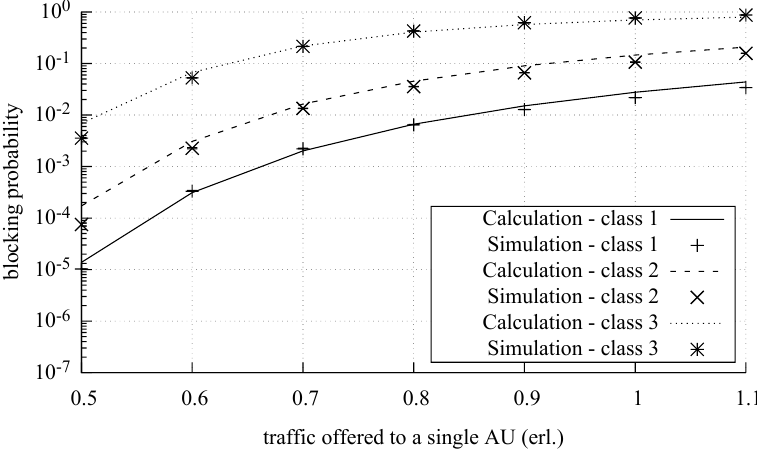
Figure 8. Blocking probability in the switching fabrics with u = 2 deactivated